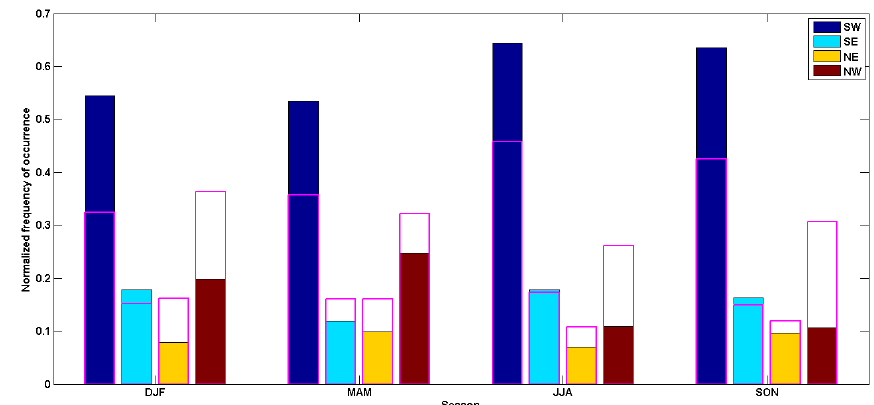
Figure 4. Seasonal normalized frequency of occurrence of a particular wind direction at 850hPa when NO 2 extreme pollution events were observed. The hollow magenta bars show normalized frequency under climatological conditions.